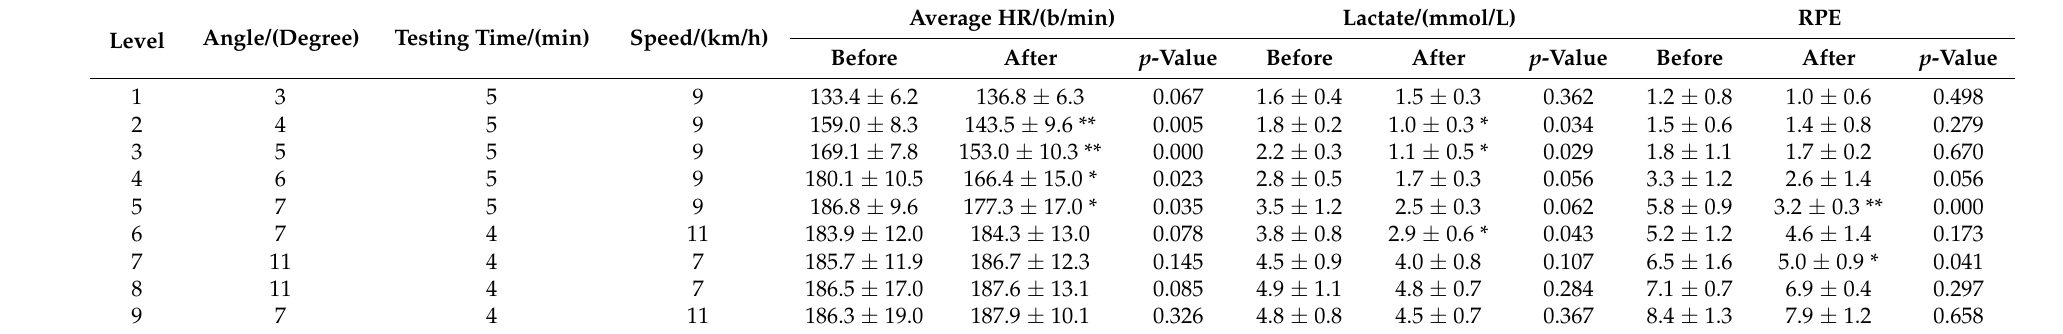
Table 8. Indicators related to the specific ability of female